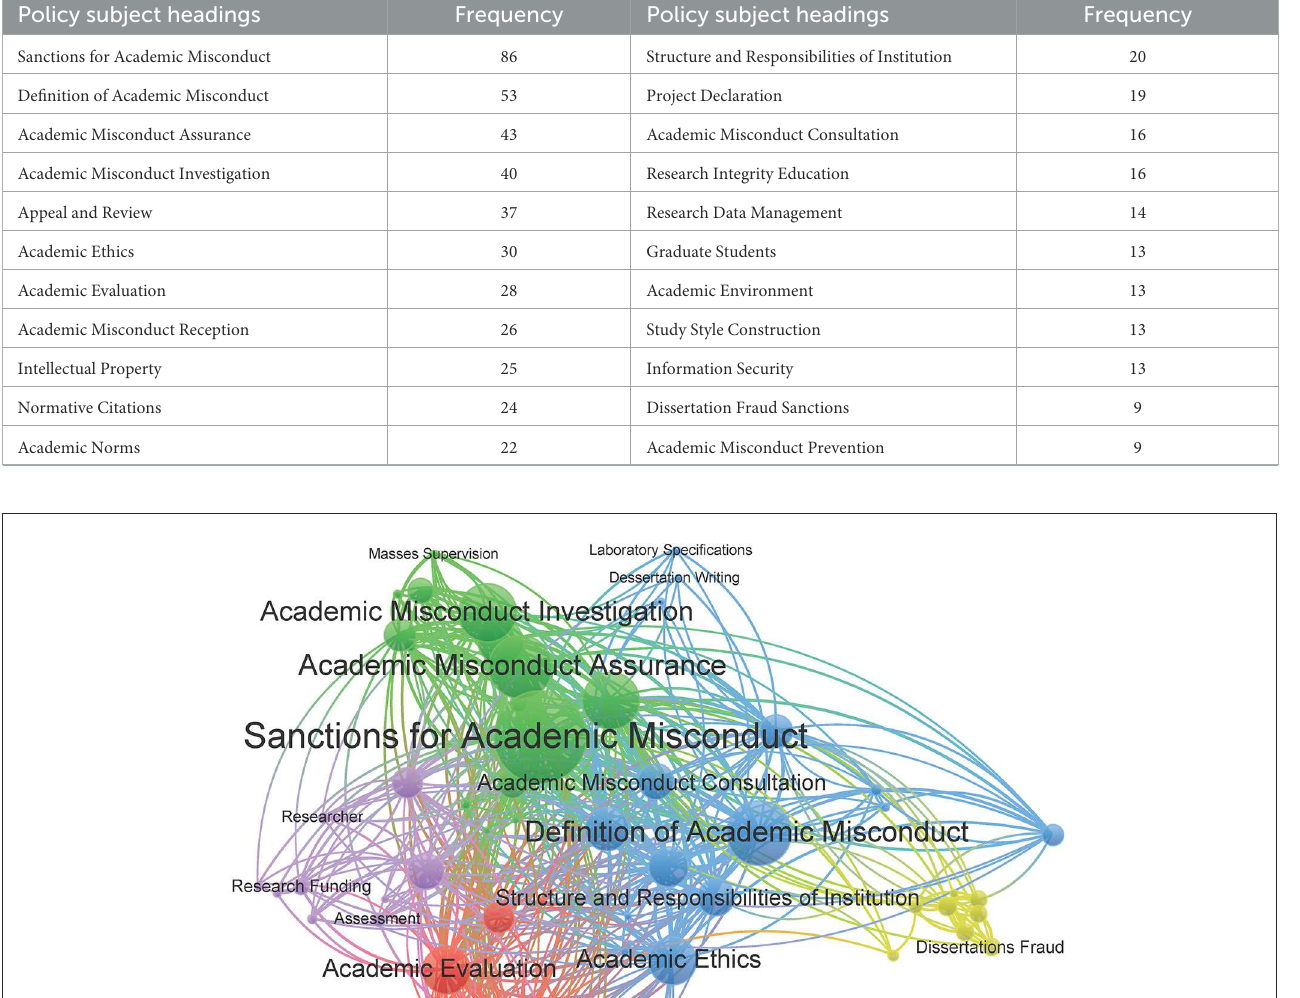
TABLE 3 High-frequency keywords for RI policy in higher education (word frequency ≥ 9).